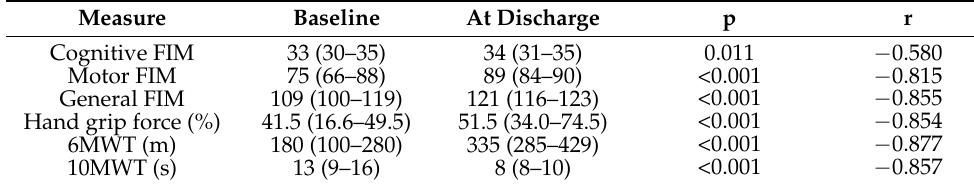
Table 2. Median and interquartile range of the functional independence measure (FIM), grip force for each hand, the 6 minute walk test (6MWT) and 10 m walk test (10MWT) ( n = 19). Data are presented at baseline and at discharge. The significance level, p, and effect size, r, are shown.